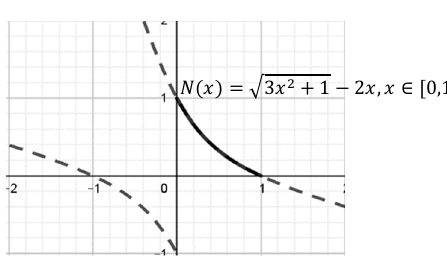
Figure 4. Conical section of hyperbola: